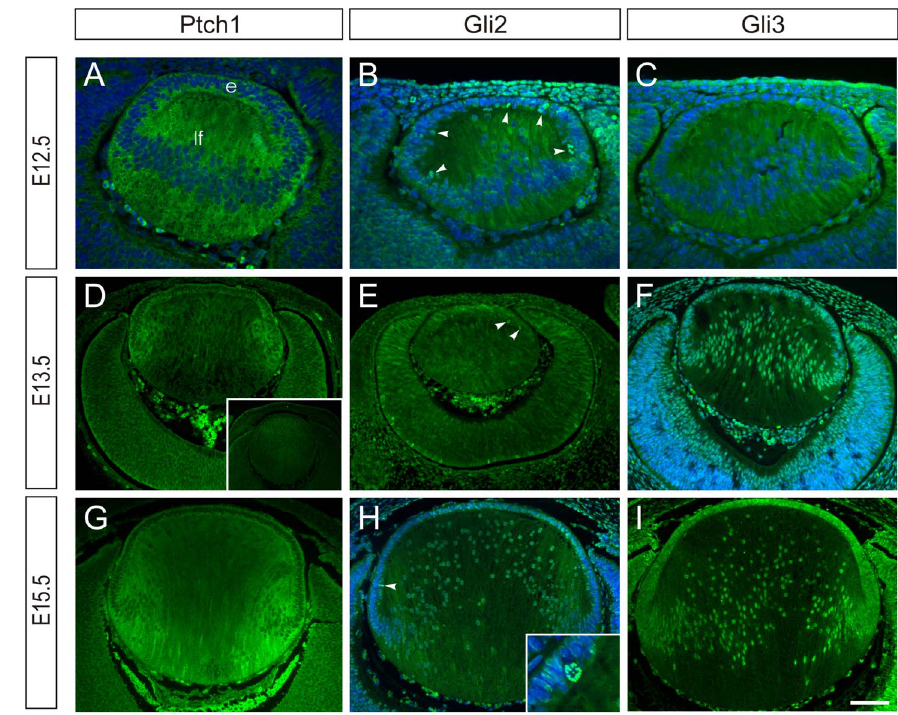
Figure 2. Localization of Hh pathway in lens. Immunolocalization of Ptch1 ( A, D, G ), Gli2 ( B, E, H ) and Gli3 ( C, F, I ) and non-immune IgG control (inset D ), in developing lens at E12.5 ( A–C ), E13.5 ( D–F ) and E15.5 ( G–I ). In the lens vesicle at E12.5 cytoplasmic and membrane reactivity for Ptch1 is found in both epithelial (e) and primary lens fibre (lf) cells ( A ). Similar patterns are seen at E13.5 ( D ) and E15.5 ( G ), with reduced reactivity present in the more differentiated fibres. Predominantly nuclear reactivity for Gli2 is detected at all ages in the epithelial cells with some nuclear and cytoplasmic reactivity detected in fibre cells ( B, E, H ). Intense reactivity for Gli2 was associated with mitotic nuclei (arrowheads B, E, H ; inset H ). Inset in H shows a metaphase nucleus, with intense reactivity for Gli2, in the epithelium of an E15.5 lens. Diffuse cytoplasmic reactivity for Gli3 was detected in the lens vesicle at E12.5 ( C ) but distinct nuclear Gli3 reactivity was detected in epithelial and fibre cells at E13.5 and E15.5 ( F, I ). Hoechst dye fluorescence (blue) in A–C, F and H show presence of nuclei. Scale bar, 50 m m ( A–C ); 100 m m ( D–I ), 230 um (inset D), 25 m m (inset, H ).